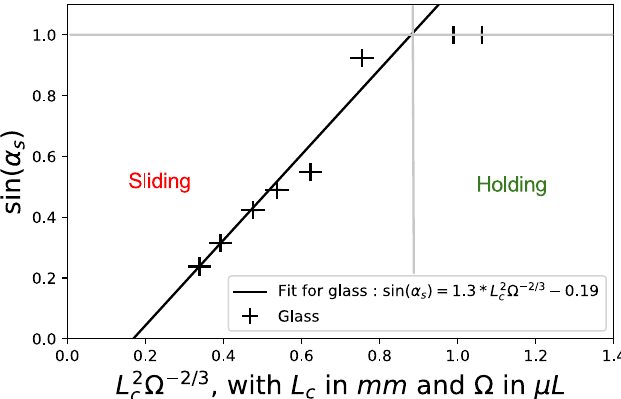
Fig. 9. Experimental results for the inclination a s needed to dislodge a drop of volume V , put on an initially horizontal plane of glass that we slowly inclined. V ranges from 15 m L to 100 m L . This graph shows that for a glass surface, the scaling law between sin a s and L c V (cid:2) 2/3 is once again reasonably valid (as it was for a plane of acrylic). What changes, compared to the previous experimental results with a plane of acrylic, is the slope of the fi t. This slope is indeed linked to the contact angles between water and the plane, which are different for a plane of glass and